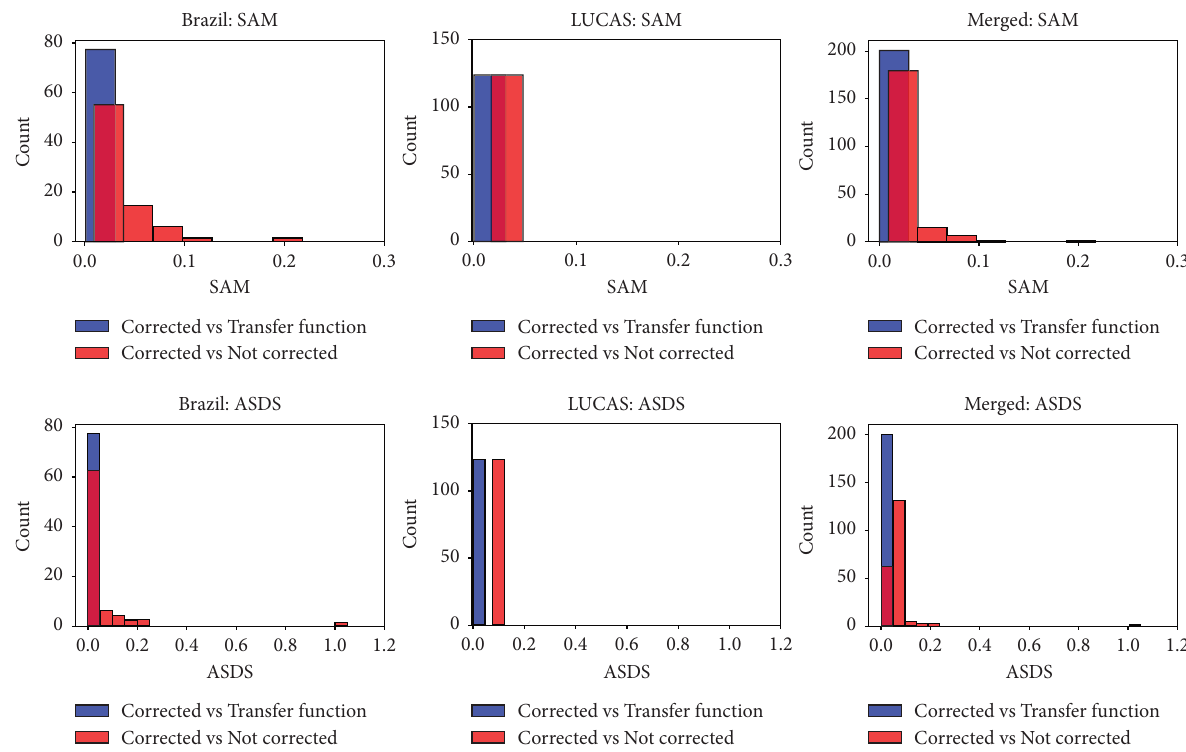
Figure 6: ASDS and SAM histograms before and after executing the TFs generated from the old–original measurements (TFs2). Table 3: Mean ASDS and SAM values before and after executing the TFs generated from the old–original measurements (TFs2).